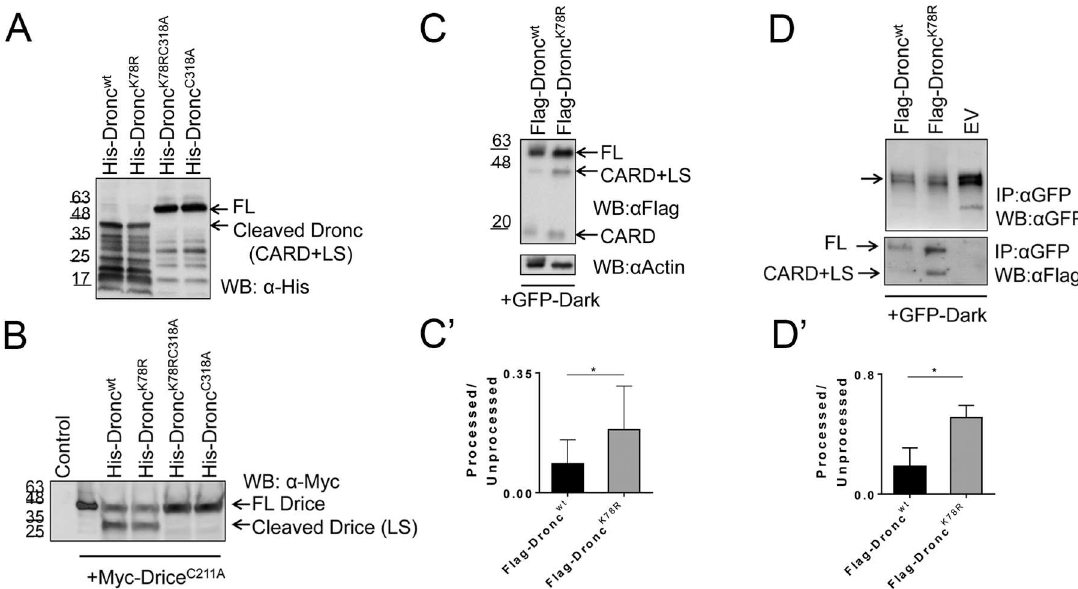
Fig 3. Biochemical characterization of Dronc K78R . ( A ) Bacterially expressed6xHis-Dronc wt and 6xHis-Dronc K78R constructs displaysimilar auto-processing activities. 6xHis-Dronc C318A and 6xHis-Dronc K78RC318A do not show any auto- processing. ( B ) In vitro caspase cleavageassays show that 6xHis-Dronc wt and 6xHis-Dronc K78R cleave Myc-Drice C211A with similar activities. 6xHis-Dronc C318A and 6xHis-Dronc K78RC318A cannot cleave Myc-Drice C211A . (C,C’) 3 rd instar lysates of da > GFP-Dark + Flag-Dronc wt and da > GFP-Dark + Flag-Dronc K78R show that in the presenceof Dark, Flag-Dronc K78R is processedsignificantly more than Flag-Dronc wt . In (C’), the averageof 4 immunoblots is plotted. ( D ) GFP-Dark interacts with Flag-Dronc wt and Flag-Dronc K78R . GFP-immunoprecipitatesof 3 rd instar larval extracts from da > GFP-Dark + Flag-Dronc wt , da > GFP-Dark + Flag-Dronc K78R and da > GFP-Dark + EV ( Flag-EmptyVector ) animals, probedwith anti-GFP antibody (upper panel)and anti-Flag antibody (lower panel). There is a stronger interaction betweenGFP-Dark and Flag-Dronc K78R , resultingin significantly more efficient processionof Flag-Dronc K78R comparedto Flag-Dronc wt . ( D’ ) Relativeratio of processedand unprocessed Flag-Dronc proteins in the Dark apoptosome. Flag-Dronc K78R is more efficiently processed than Flag-Dronc wt . The averageof 3 immunoblots is plotted. For quantifications, the student’s t-test was used. Error bars are SD. * P <